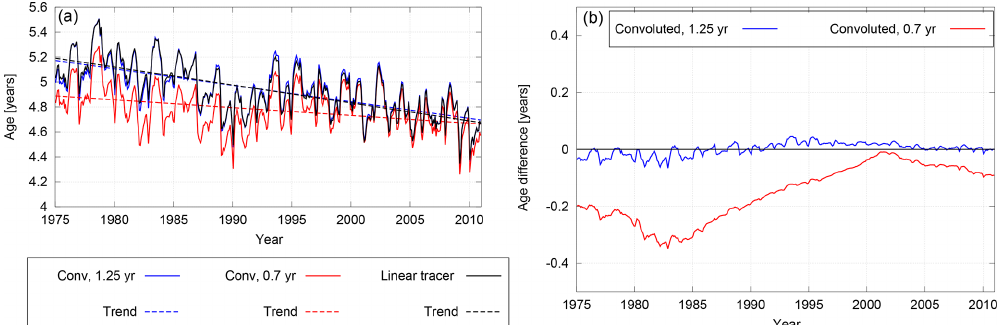
Figure 15. (a) Mean AoA and its trend derived from SF 6 using the convolution method for 0.7- and 1.25-year ratios of moments (red and blue) and from the linear tracer (black) at 20hPa and 40 ◦ N from 1975 to 2011 from the RC1-base-07 simulation. (b) The difference in mean AoA derived from SF 6 and the linear tracer.